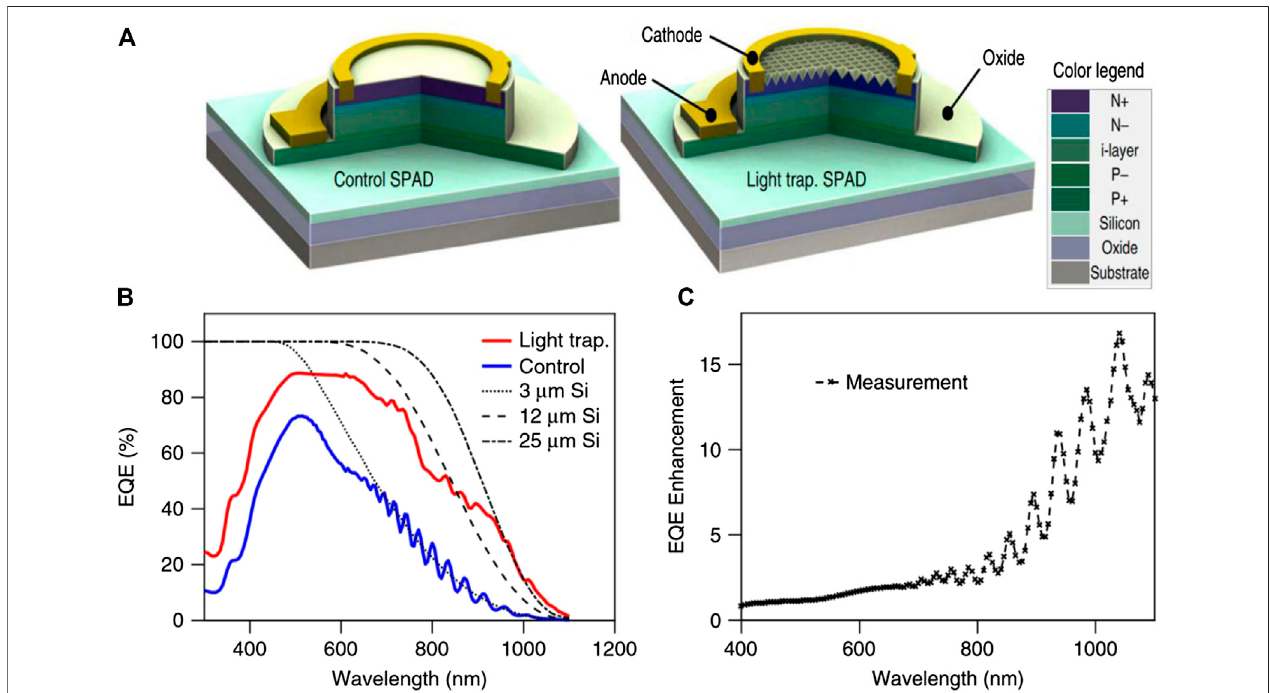
FIGURE 7 | (A) Schematic diagram of truncated cone-shaped metamaterial absorber. (B) The re fl ection, absorption, and transmission characteristics of the absorber. Source : reproduced from Ref. 74.